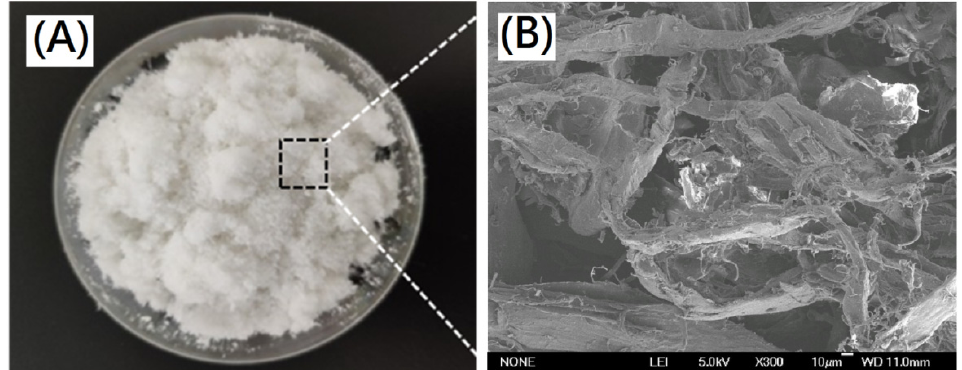
Figure 8. ( A ) Photograph of the resulting decellularized nano-bioscaffold microparticles and ( B ) SEM photograph of the resulting decellularized nano-bioscaffold microparticles(scale bar indicates 10 μ m).